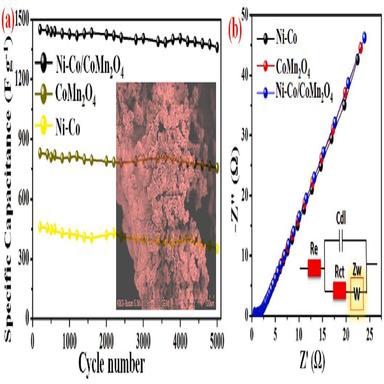
(a) EIS test of Ni-Co, CoMn2O4, and Ni-Co/CoMn2O4 nanomaterials composite electrodes. (b) Cycling performances of the Ni-Co, CoMn2O4, and Ni-Co/ CoMn2O4 nanomaterials electrodes at a current density of 3 A g− 1 .